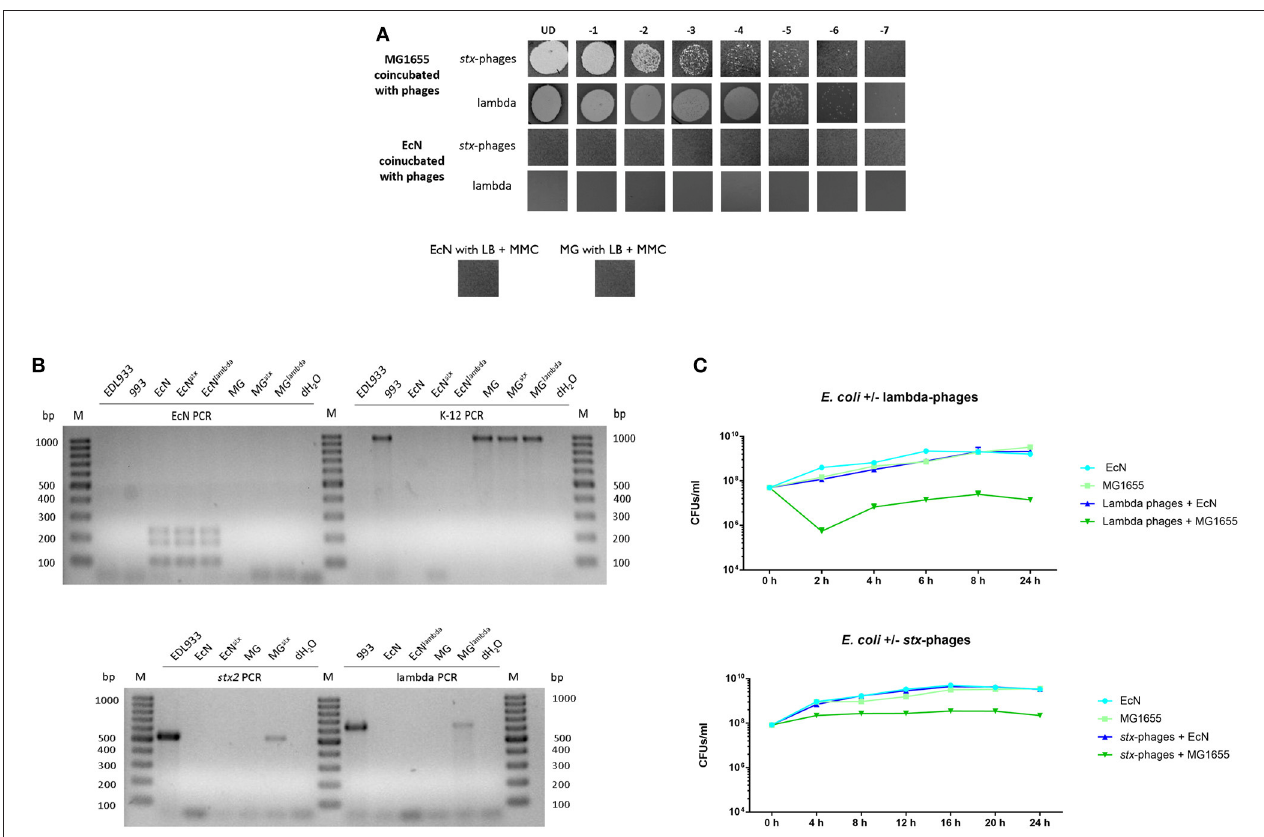
FIGURE 1 | EcN test results for lysogeny by stx -/lambda -phages. (A) EcN and MG1655 were tested for lysogeny with stx -/lambda-phages. The E. coli strains were incubated with the respective phages for a period of 44 h ( stx -phages, MOI: 100:1 = E. coli : phages) and 72 h (lambda-phages, MOI: 10:1 = E. coli : phages). Then they were forced to lyse by the addition of 1 µ g/ml Mitomycin C (MMC). The phage signal was intensified by another incubation period with MG1655. The final phage titer was determined by a MG1655 Phage Plaque Assay (PPA). EcN and MG1655 + MMC served as negative control for lysogeny. (B) After a 24 h incubation period with (EcN/MG1655 stx / lambda ) or without (EcN/MG1655) stx - or lambda-phages EcN and MG1655 bacterial colonies were collected and tested for lysogeny with the stx2 primers or the lambda Q primers respectively. The strain identity was confirmed with the genome specific EcN primers 1L/R, 4L/R, 5L/R, and the K-12 primers. (C) The growth kinetics of EcN/MG1655 were determined in presence and absence of lambdoid phages during a period of 24 h. M, 100 bp ladder.